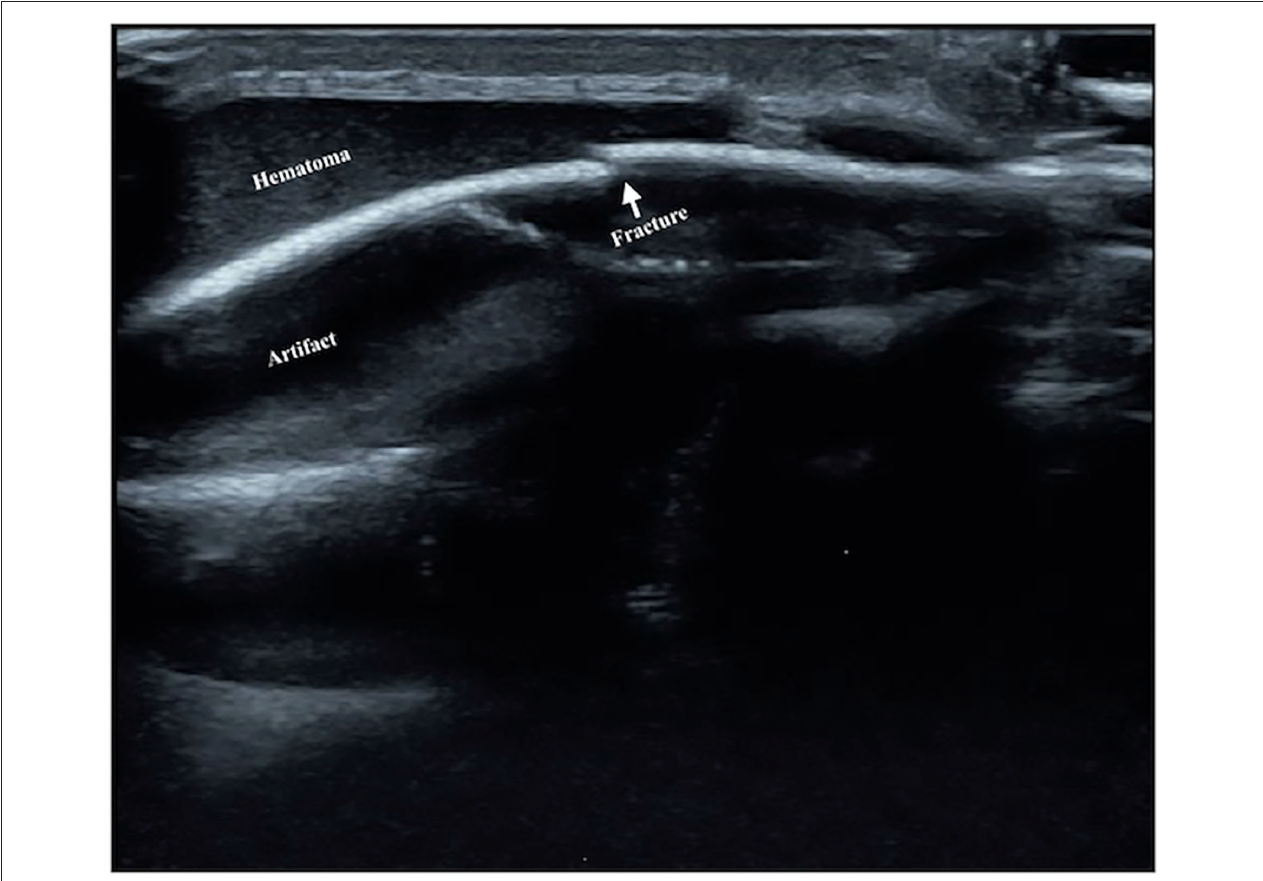
FIGURE 6 | Skull fracture. The infant is G 1 P 1 with a gestational age of 39 + 2 weeks, vaginal delivery, and birth weight of 3,940g. He suffered from severe asphyxia at birth and was diagnosed with HIE and cranial hematoma on the top of the left head on admission. Brain ultrasound revealed that the continuity of the skull bone under the hematoma was interrupted, and the formation of broken ends with slight dislocation and separation was seen, which suggested the presence of a skull